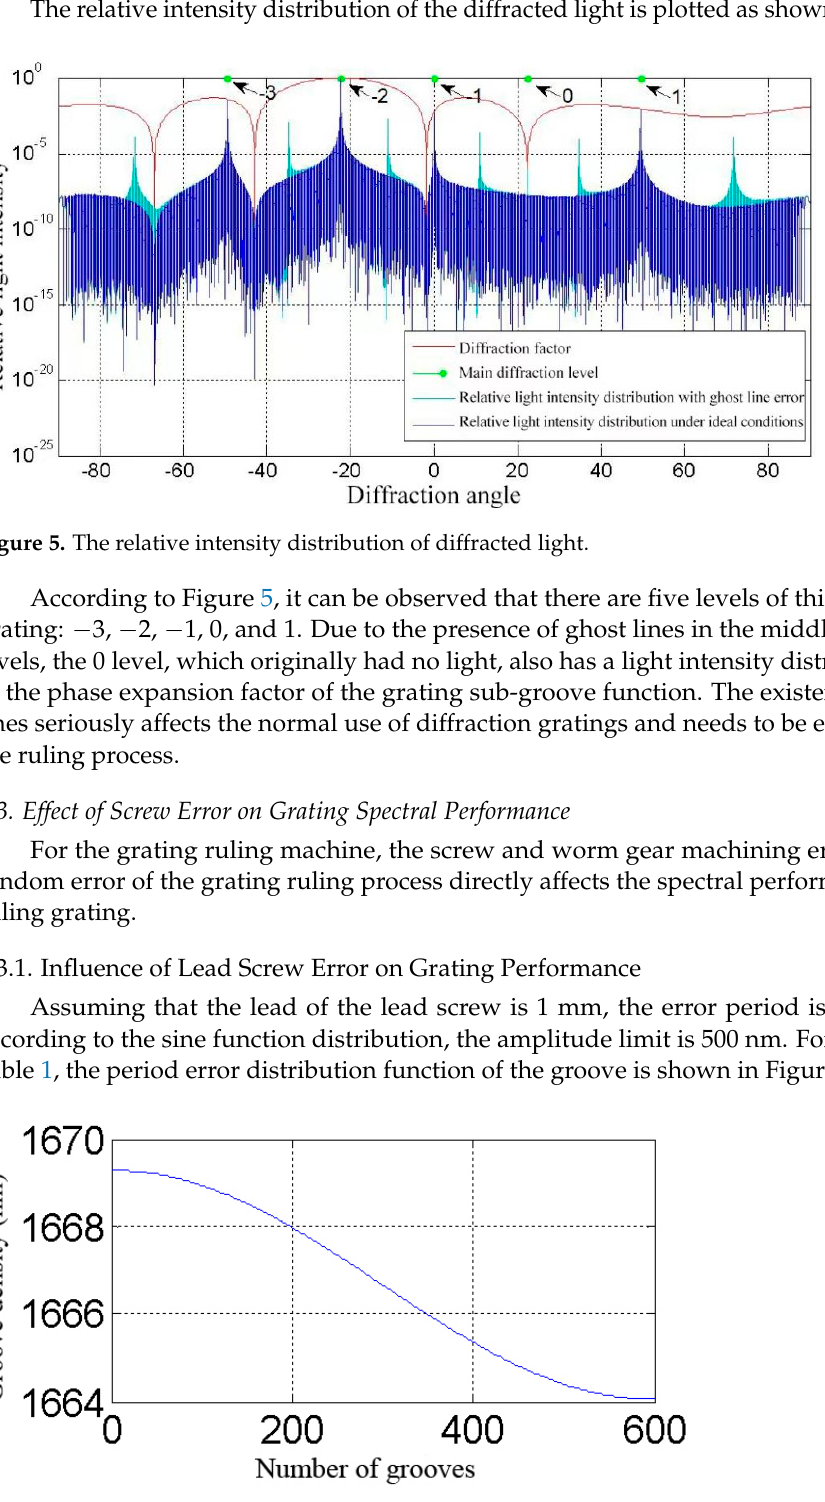
Figure 7. The relative intensity distribution of diffracted light. It can be observed from Figure 7 that the periodic error of the screw does not produce obvious ghost lines, but only enhances the stray background of the diffracted light distri- bution. Therefore, the screw error is one of the causes of the grating stray light. 2.3.2. Effect of Worm Gear Error on Grating Spectral Performance For the grating ruling machines, the worm gear error will also affect the ruling accu- racy of the grating. In order to analyze the influence of the worm gear error on the ruling quality of the grating, we assume an error for the worm gear, as shown in Figure 8, and then according to Equation (19), the grating diffraction spectrum distribution with the worm gear error can be obtained, as shown in Figure 9.